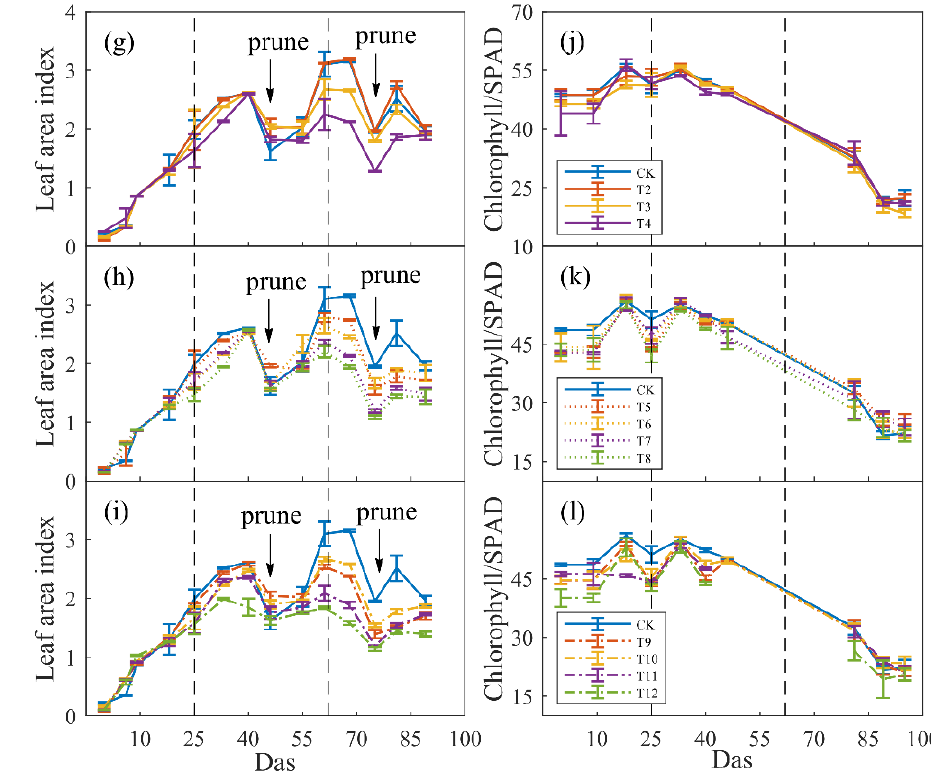
Figure 2. The plant height (h), stem diameter (D), leaf area index (LAI) and chlorophyll content (SPAD) under different water and nitrogen treatments in the second season of 2019. Notes: ( a , d , g , j ) show sufficient irrigation groups of CK, T2, T3 and T4, respectively; ( b , e , h , k ) represent moderate water deficit groups of T5, T6, T7 and T8, respectively; ( c , f , i , l ) indicate severe water deficit groups of T9, T10, T11 and T12, respectively.